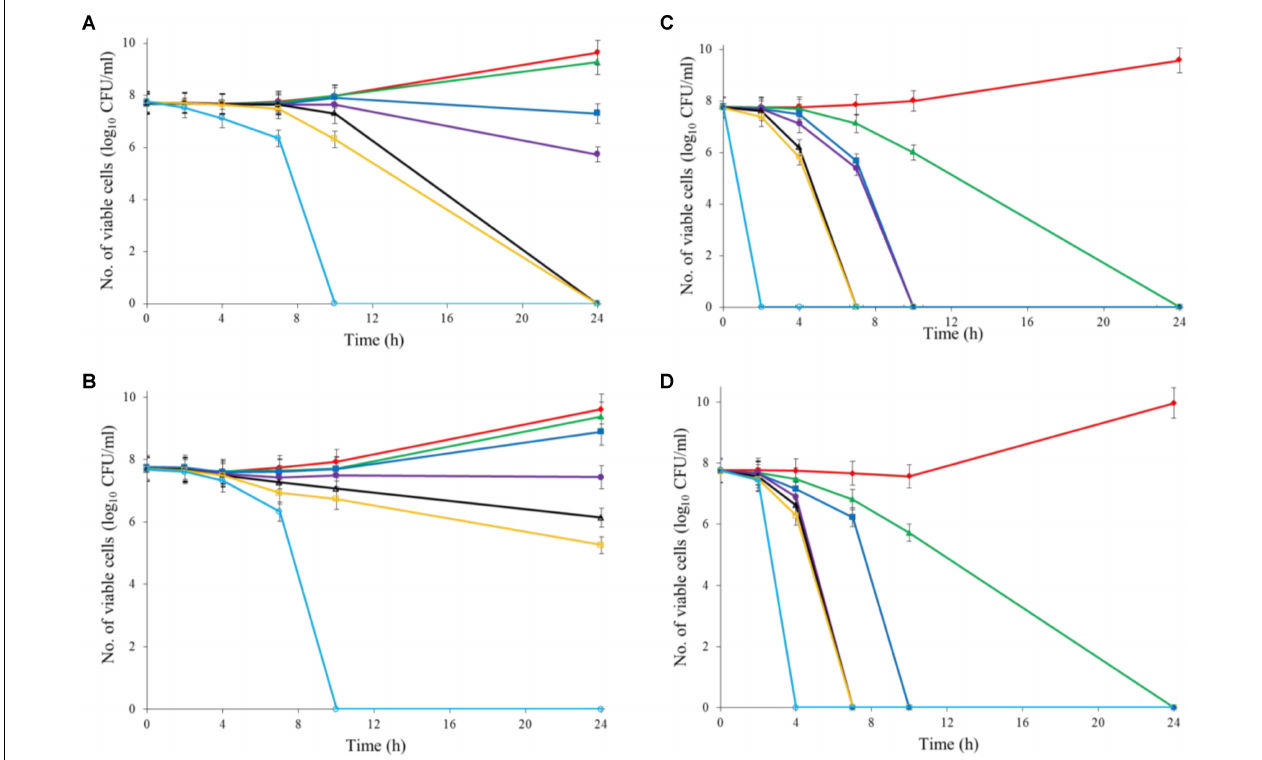
FIGURE 3 | Synergistic antimicrobial effect of ajoene and metal oxide nanoparticles against C. jejuni cocktail (the mixture of C. jejuni strain F38011, ATCC 33560, y110539, and z110526) at 37 ◦ C. (A) Antimicrobial effect of TiO 2 nanoparticles. (B) Antimicrobial effect of Al 2 O 3 nanoparticles. (C) Synergistic antimicrobial effect of 0.06 mM ajoene and TiO 2 nanoparticles. (D) Synergistic antimicrobial effect of 0.06 mM ajoene and Al 2 O 3 nanoparticles. Different symbols indicate different concentrations of metal oxide nanoparticles (red line: 0 mM; green line: 0.5 mM; blue line: 1 mM; purple line: 2 mM; black line: 4 mM; orange line: 8 mM; light blue line: 16 mM) ( n =